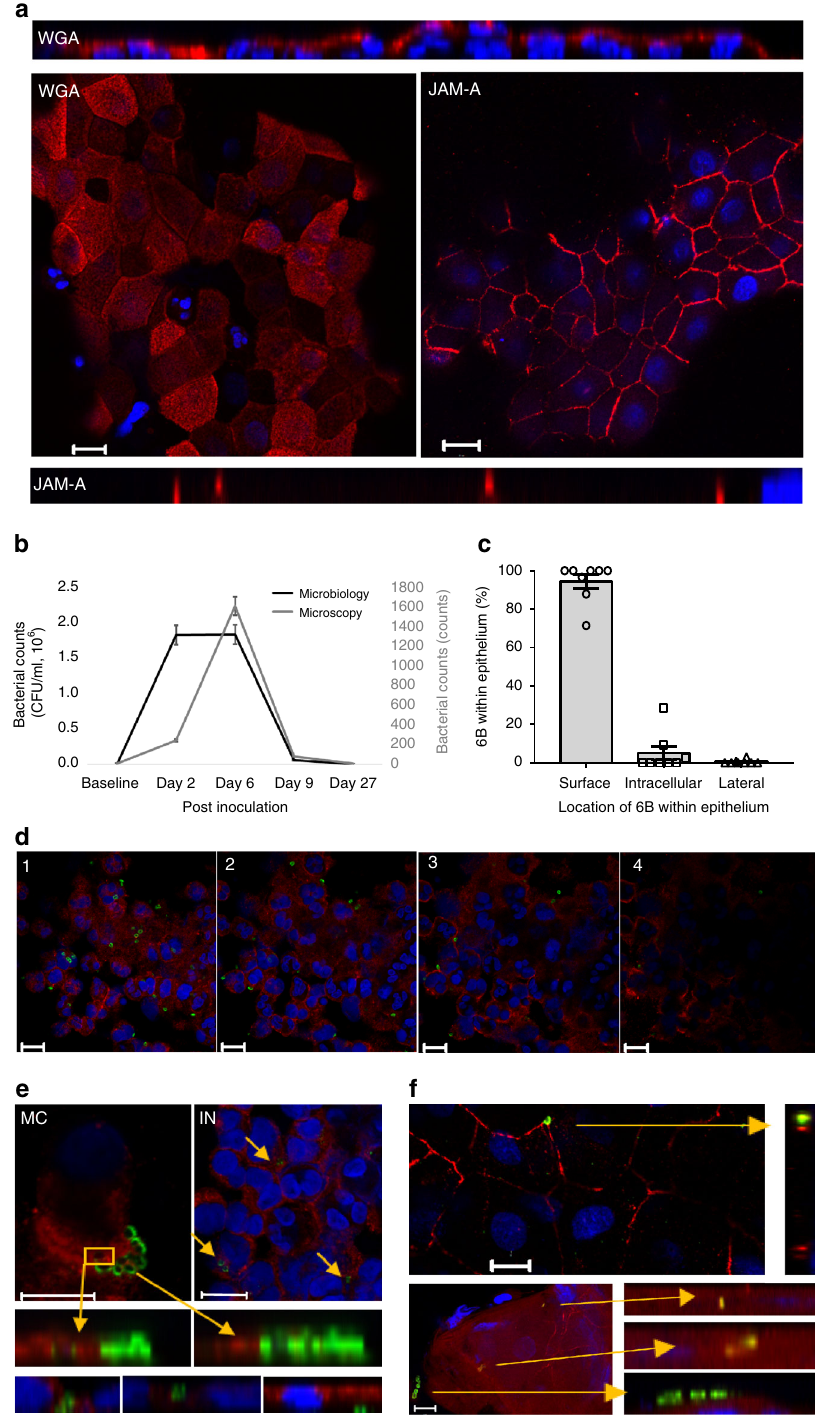
Fig. 1 Pneumococcal colonisation in the EHPC model is associated with adhesion, micro-colony formation and micro-invasion. a Representative fi elds from the EHPC model nasal curette biopsies show intact epithelium can be obtained from the samples (as visualised by XY planes) and they retain their size and shape (as visualised by XZ planes). Cells were stained with wheat germ agglutinin (WGA) or junctional adhesion molecule-A (JAM-A, red) and nuclei (blue). b The pattern of pneumococcal density detected by culture and microscopy. The total bacterial sum across volunteers is shown. c The proportion of bacteria located on the cell surface, intracellularly, or paracellularly visualised by confocal microscopy, quanti fi ed from eight volunteers collected over time from microscopy counts. b , c Error bars represent s.e.m. d Cells were stained for surface carbohydrates using WGA (red), and the bacteria were marked with speci fi c serotype antiserum (green). XY images of 1 µ m slices through a layer of cells from top (stack 1) to bottom (stack 4), with bacteria associated. e Examples of cells collected on day 6 post inoculation stained with WGA (red) showing; (MC) micro-colony formation on the surface of the epithelium, (IN) bacterial internalization, (TM) transmigration through epithelial uptake internally or between cells. f Co-association between S. pneumoniae (green) and JAM-A (red). Nuclei (blue). Bacterial uptake appeared co-associated with JAM-A (yellow). All scale bars represent 10 μ